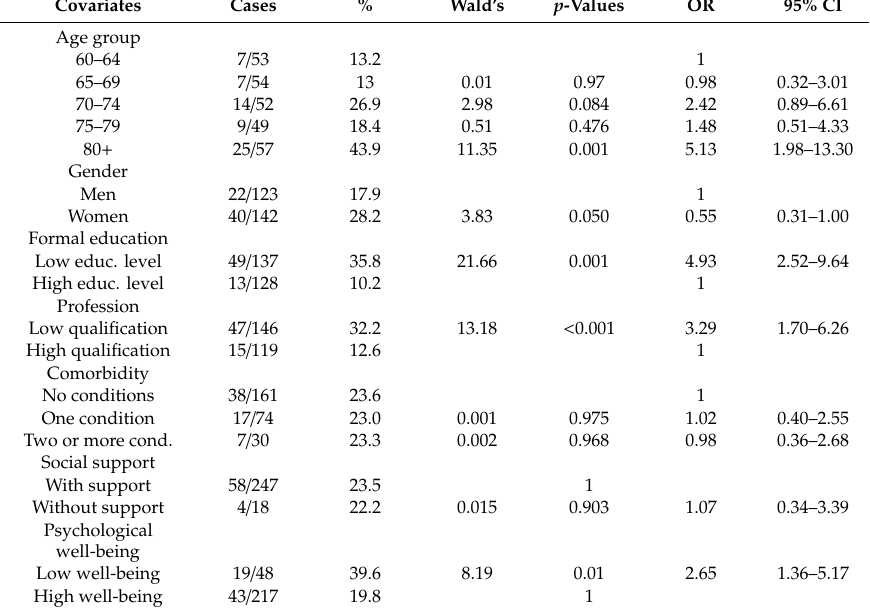
Table 2. Prevalence of cognitive frailty (CF) according to age, gender, formal education, profession, social support status, and psychological well-being (univariate logistic